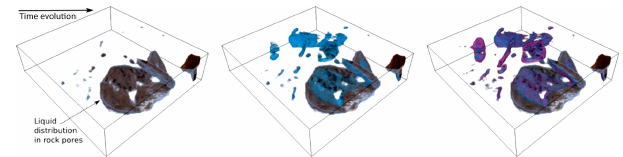
Figure 3. Time series showing the wetting of sandstone gravel un- der the first drip (3-D frame acquisition frequency = 0.07/3-D vol- ume, 14Hz). The first frame shows the dry sample with the sand- stone grains rendered in semi-transparent grey. From the second frame the KI solution is shown in blue. The rendered volume is ap- proximately 3.5mm × 3.5mm × 2mm. For further explanation and labeling of identified patches A–H, see Dobson et al.